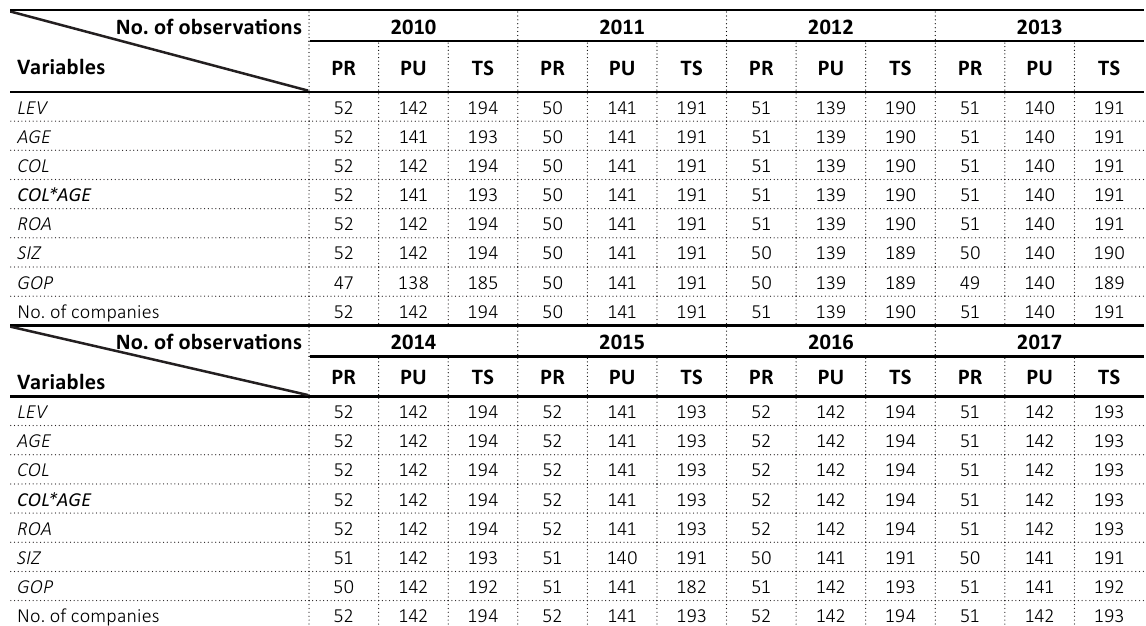
Table 2. Distribution of samples over time